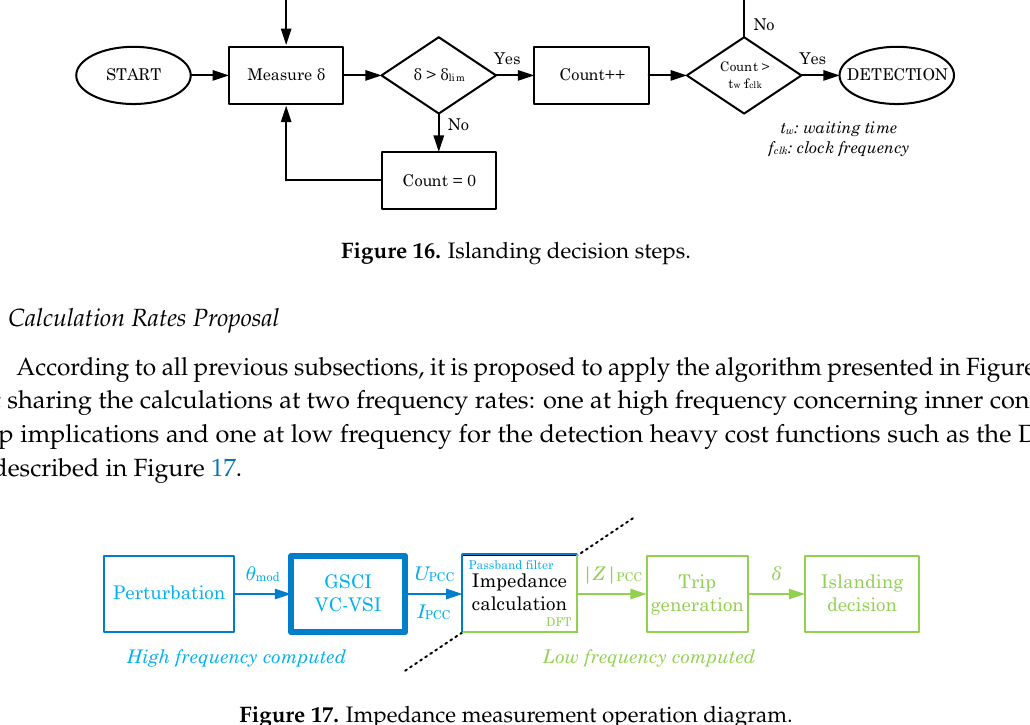
Figure 17. Impedance measurement operation